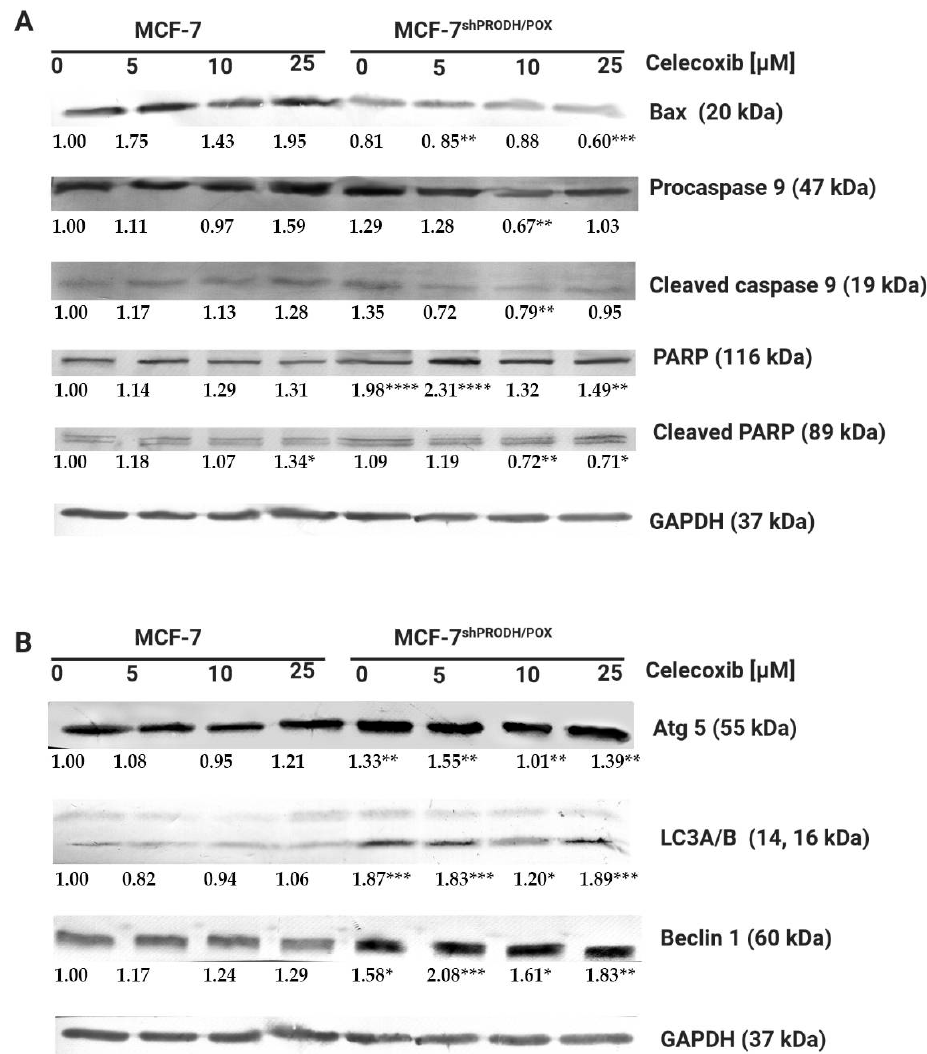
Figure 2. Celecoxib induces apoptosis in MCF-7, while in MCF-7 shPRODH/POX cells, autophagy occurs: ( A ) Western blot analysis of protein markers for apoptosis; ( B ) Western blot analysis of protein markers for autophagy. Representative blot images were shown (the mean value of densitometric analysis of protein bands presented below each blot; * p < 0.05, ** p < 0.01 and *** p < 0.001, **** p < 0.0001). Supplementary materials contain statistical analysis of the evaluated proteins.